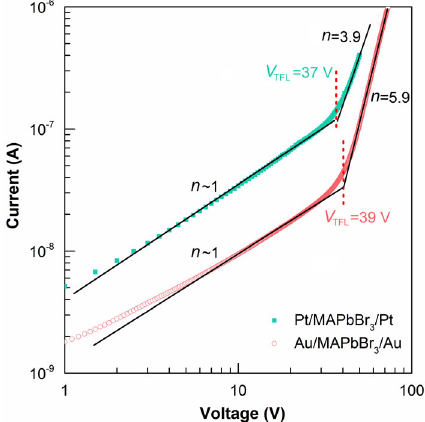
Fig. 5 HRS of MAPbBr 3 single crystals with Au and Pt electrodes in a log–log scale. Characteristic I–V traces show two different regimes. A linear ohmic regime ( I V  ) is followed by the trap-filled regime ( 3 n I V   ). In the SCLC model, n is an exponent and n >3 indicates the trap-filled conduction